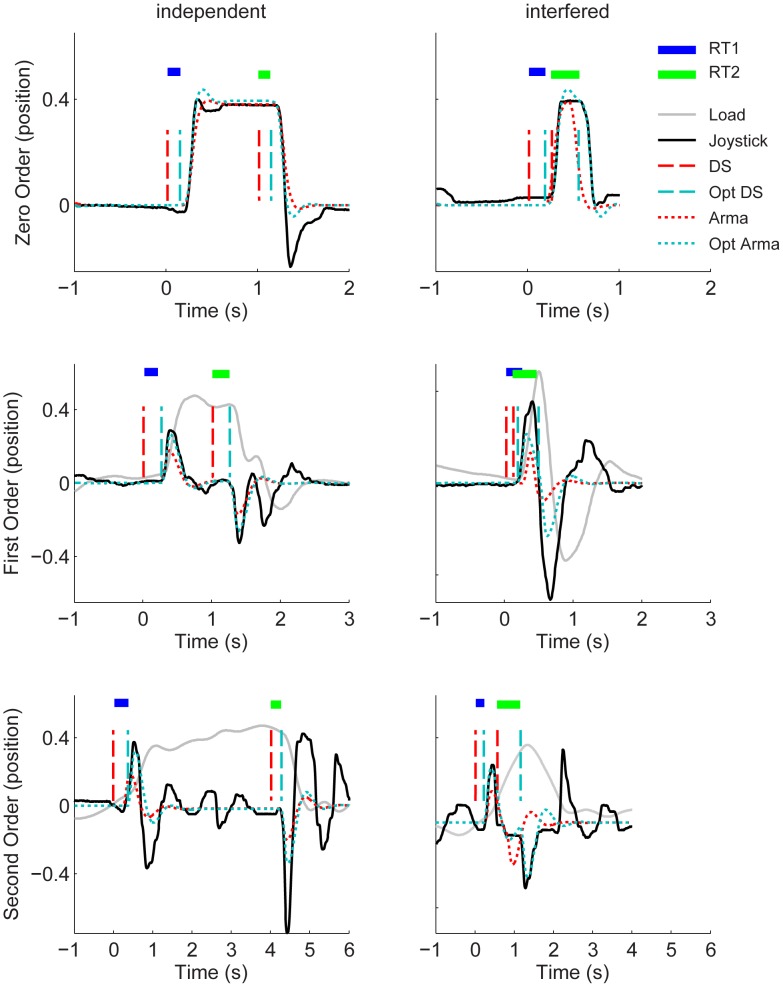
Representative responses; reconstruction of the set-point (stage 1).Panels show representative examples of positional joystick responses over time (blue solid lines) in: Zero Order (top row), First Order (middle row), and Second Order (bottom row) conditions. Left panels show independent responses without interference, right panels show trials with interference between responses to the second and first stimulus. The dashed line (red) shows the time-invariant optimized ARMA fit corresponding to the original/actual double step stimulus (dark blue dashed line). The dotted line (green) shows the best fitting ARMA model corresponding to the non-time-invariant optimised step sequence (dark green dotted line). Estimates of first (RT1 in blue horizontal bar) and second (RT2 in green horizontal bar) delays hover above, and span the interval between the actual and optimised step sequence. System position is displayed by the solid gray line; this is the same as joystick position in the Zero Order case.